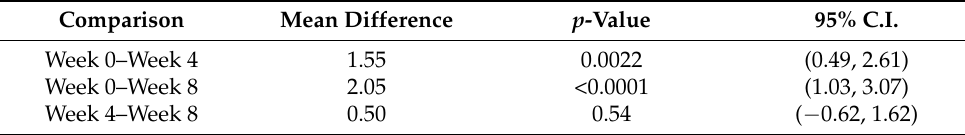
Table 2. Results of Tukey’s multiple comparison procedure for